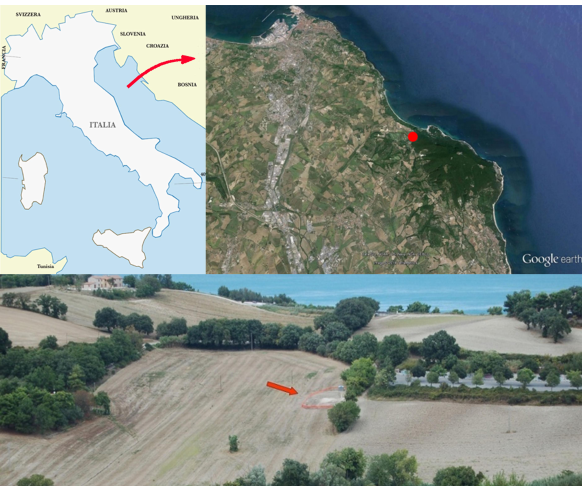
Figure 1: Localization of the